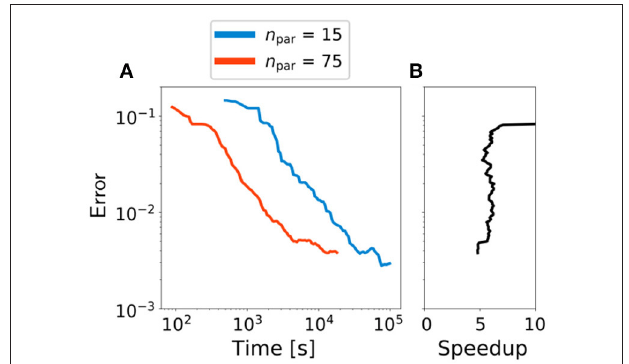
FIGURE 9 | Error between ˆ µ k and µ ex for a fixed n max = 25, l 0 = 100 and variable n par (A) , and the speedup factor for obtaining the same error accuracy (B)